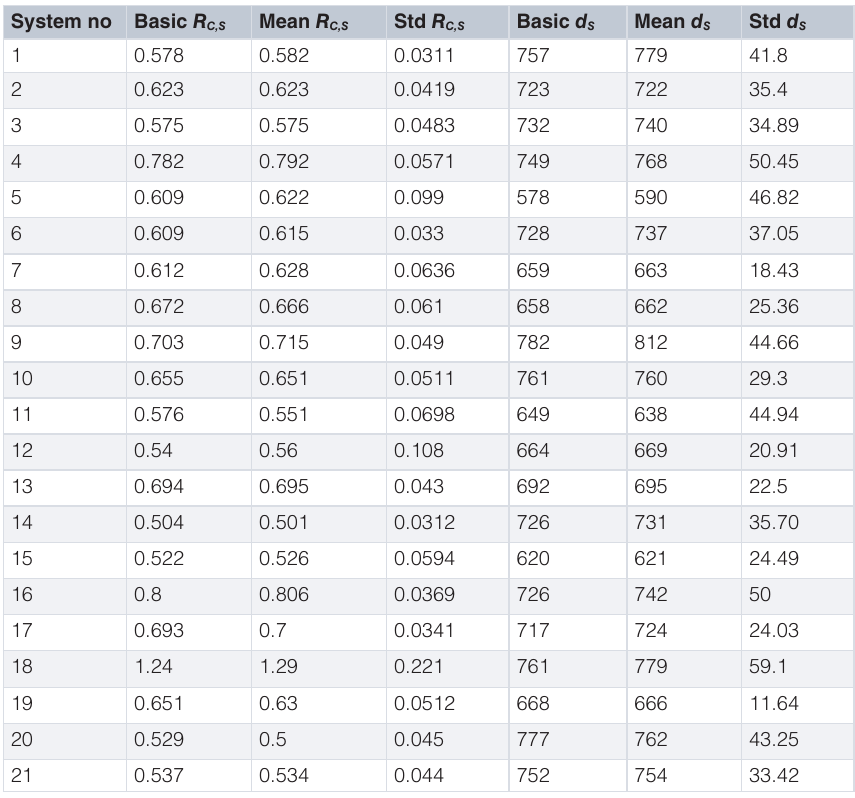
Table 4. For 21 systems with R C,S > 0.5 and d S < 800, we re-calculate R C,S and d S < 800 from 20 variations on concentration values within a 20% interval. Shown are the original, the mean and std